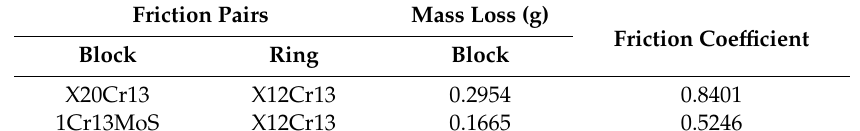
Table 2. Results of friction test.